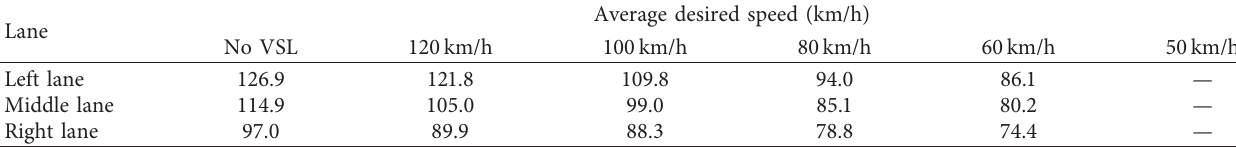
Table 1: The average vehicle speed with a headway greater than 5 s at different VSLs in each lane. Lane